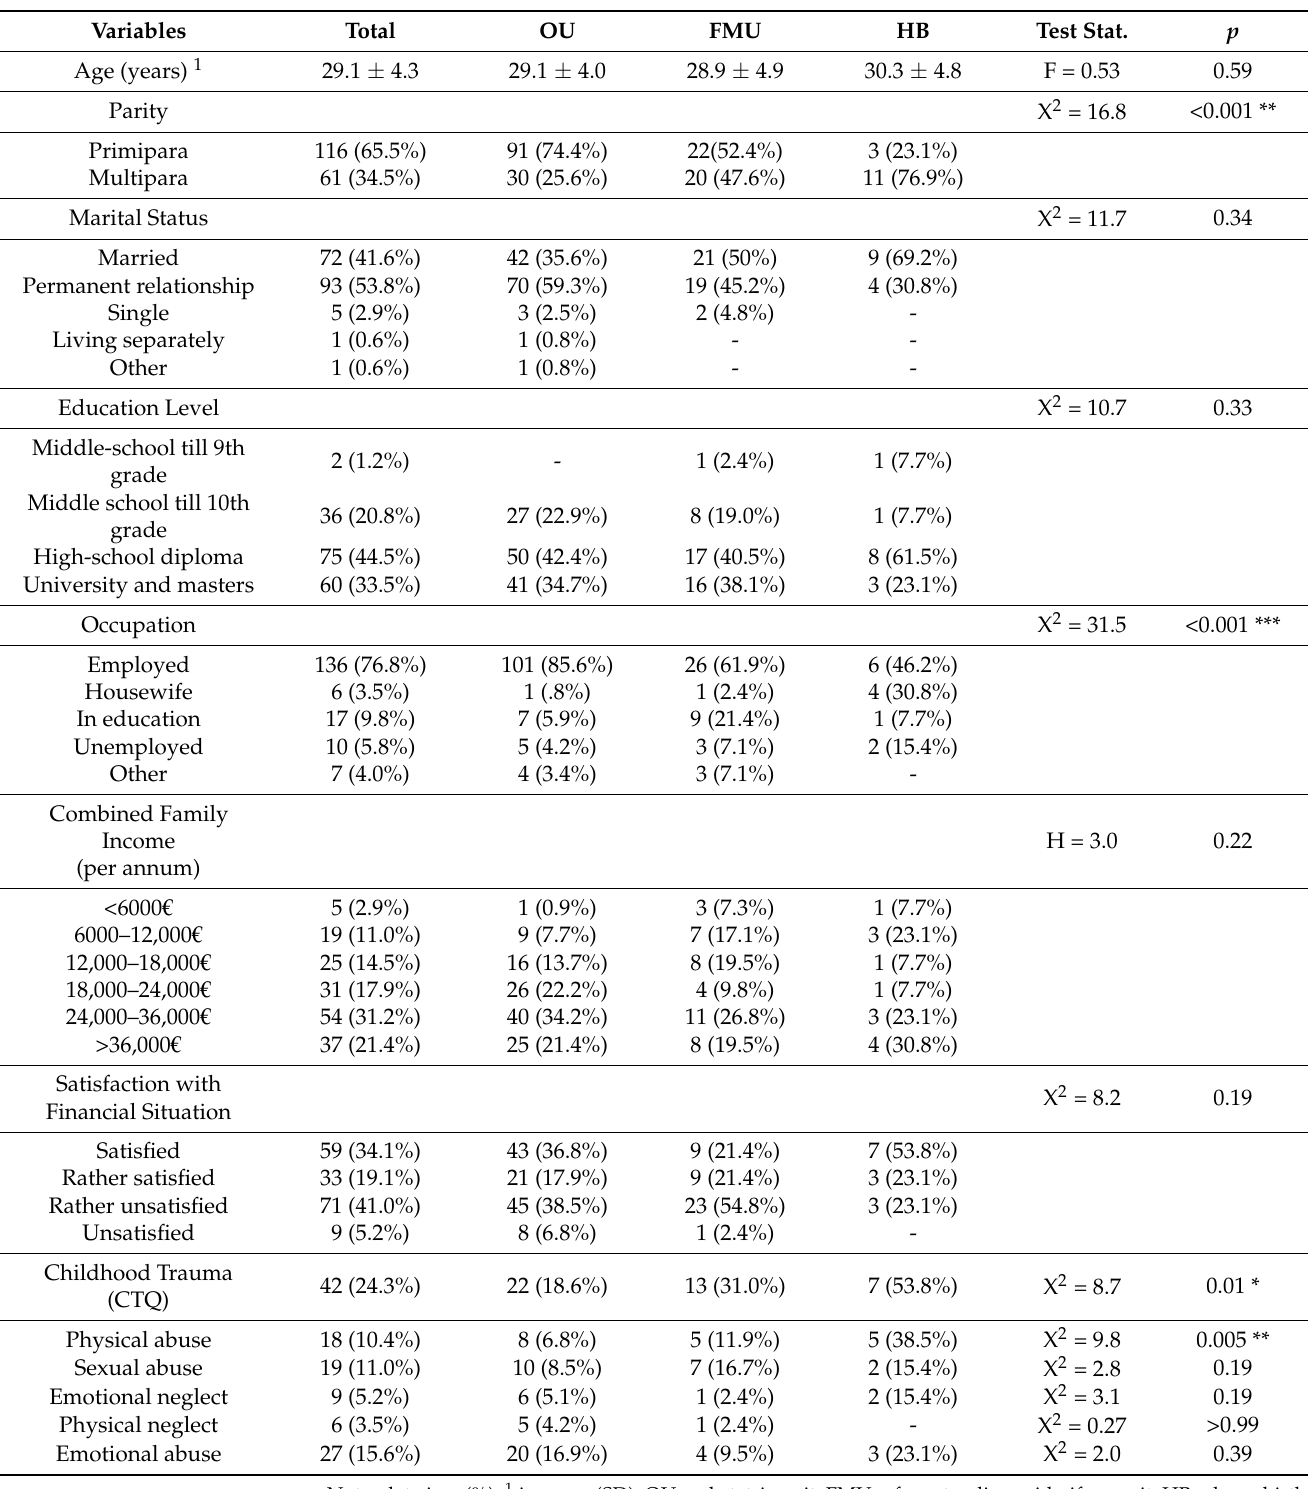
Table 1. Background characteristics of n (%) in the total sample, according to planned